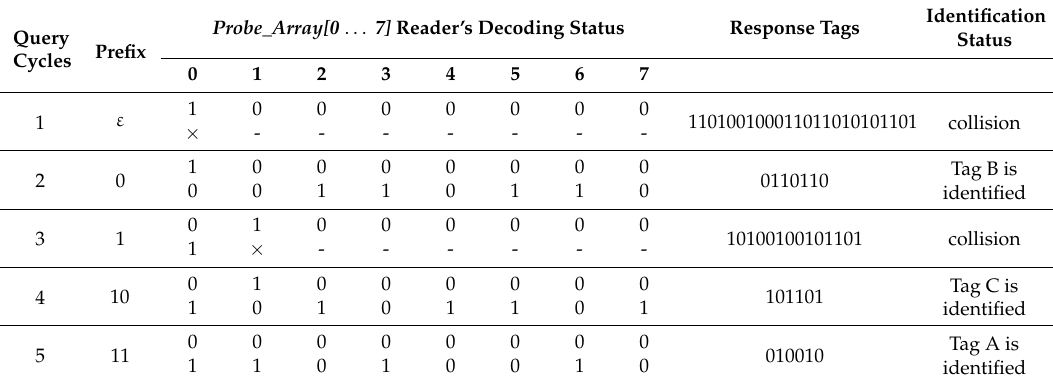
Table 1. The execution of the array scheme.